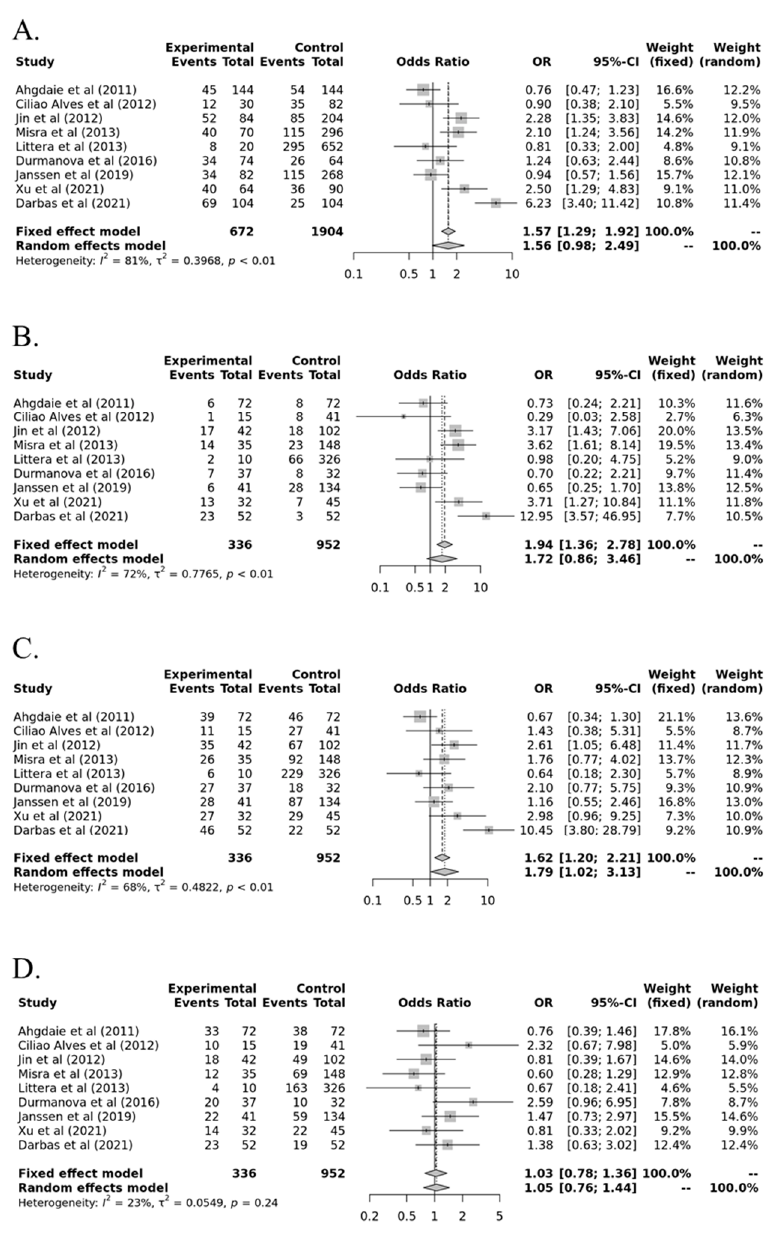
Figure 2. Forest plots in genetic models between HLA-G polymorphism (14-bp insertion/deletion ( rs16375 )) and susceptibility to acute rejection in kidney transplant recipients. ( A ) Ins vs. Del; ( B ) Ins/Ins vs. Ins/Del+Del/Del; ( C ) Ins/Ins+Ins/Del vs. Del/Del; ( D ) Ins/Del vs. Ins/Ins+Del/Del.